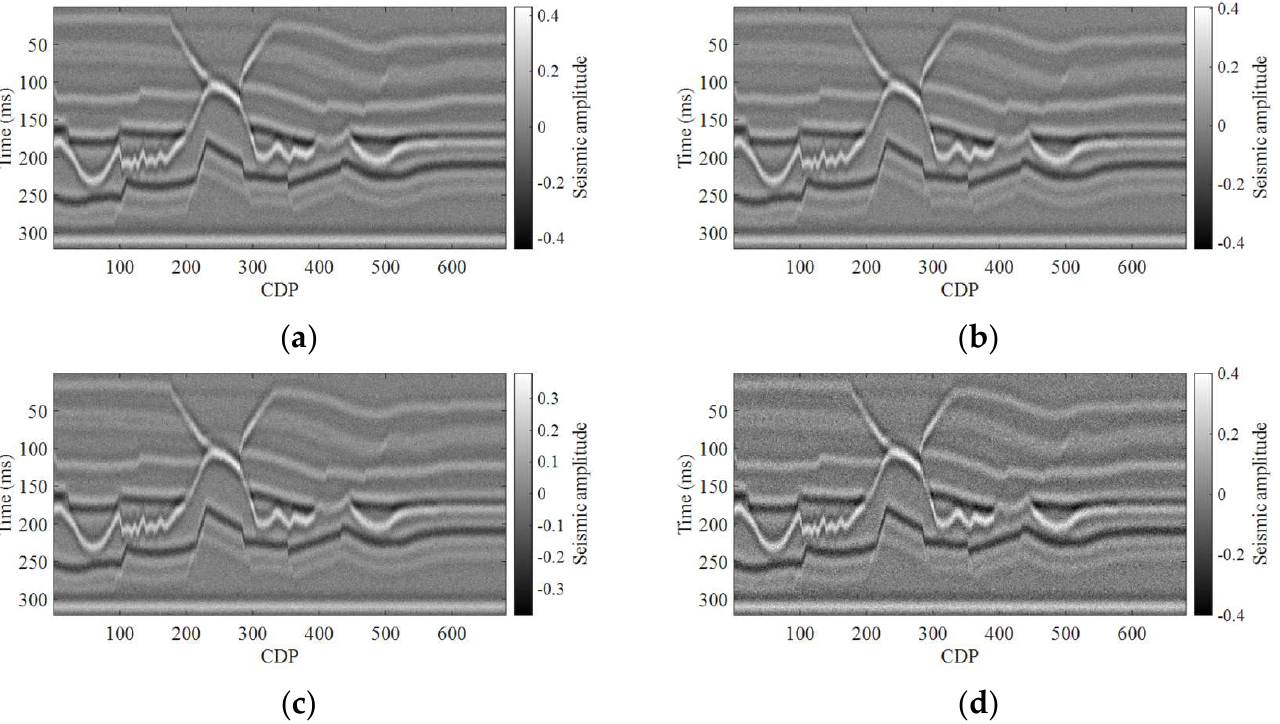
Figure 5. The observed noisy prestack angle gathers of ( a ) 0°, ( b ) 15°, and ( c ) 30° for seismic inversion. ( d ) The noisy poststack seismic record used for initial model building.